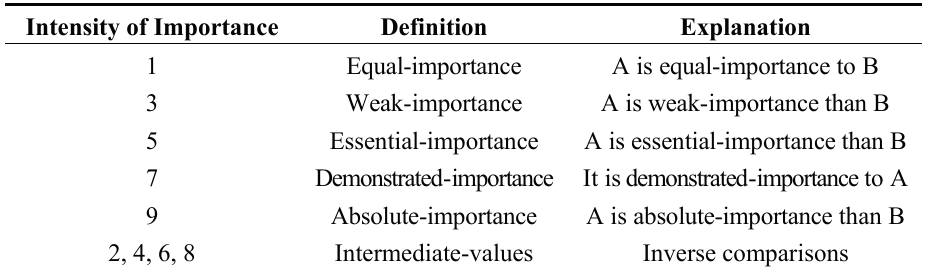
Table 2. The pair-wise comparison